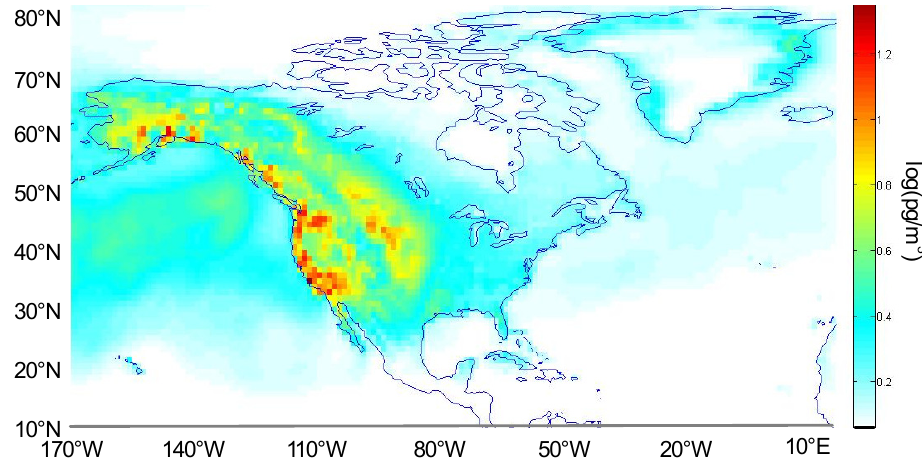
Figure 5. Annual mean BaP concentration (pg/m 3 ) at 10 m above ground level induced by Asian Fig. 5. Annual mean BaP concentration (pgm − 3 ) at 10m above ground level induced by Asian emission sources in emission sources in 2004.